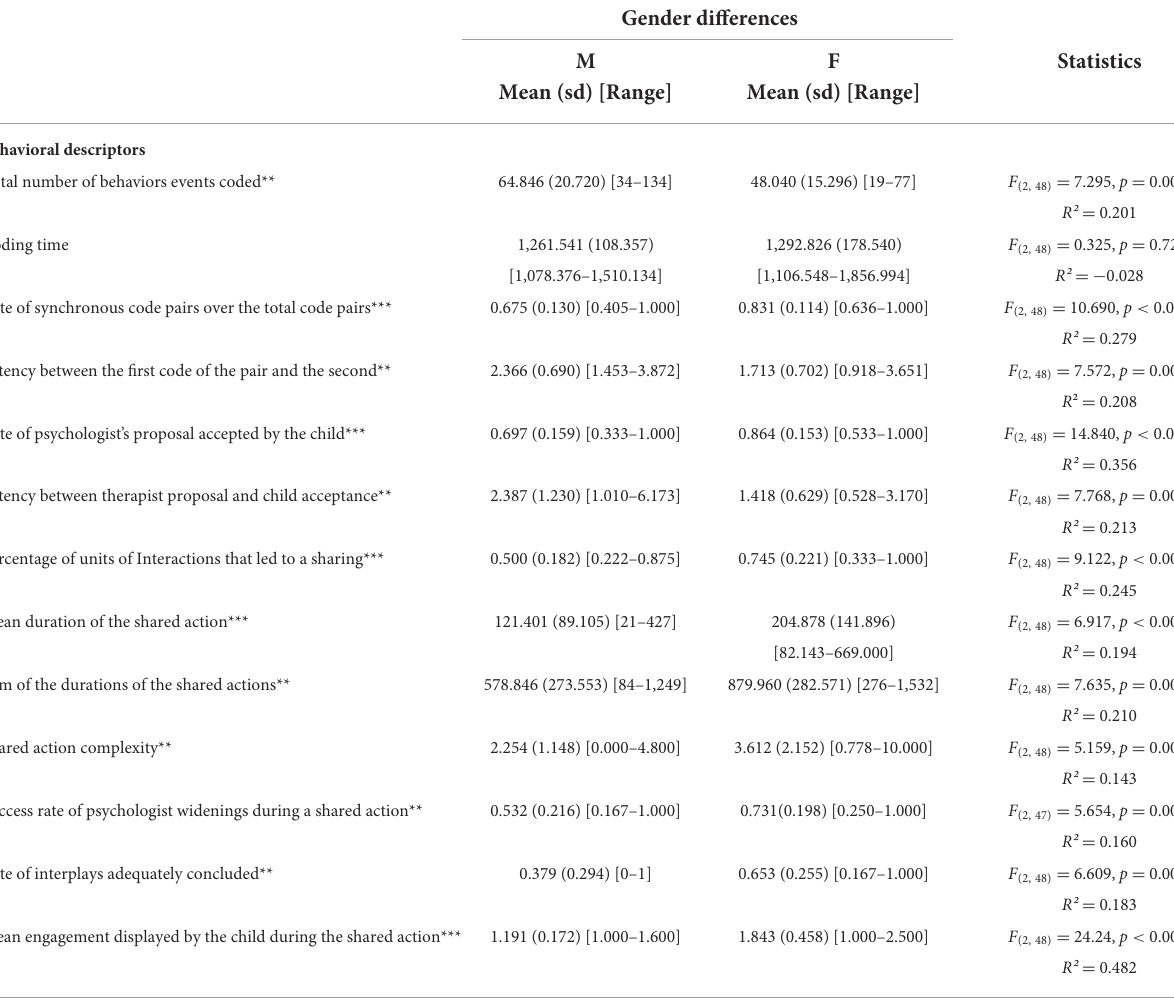
TABLE 4 Gender differences in behavioral descriptors.